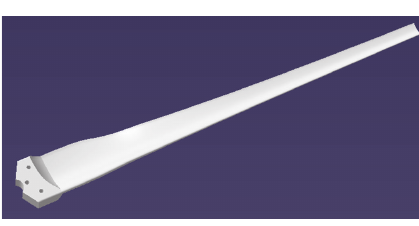
Figure 5: Model of bionic blade.